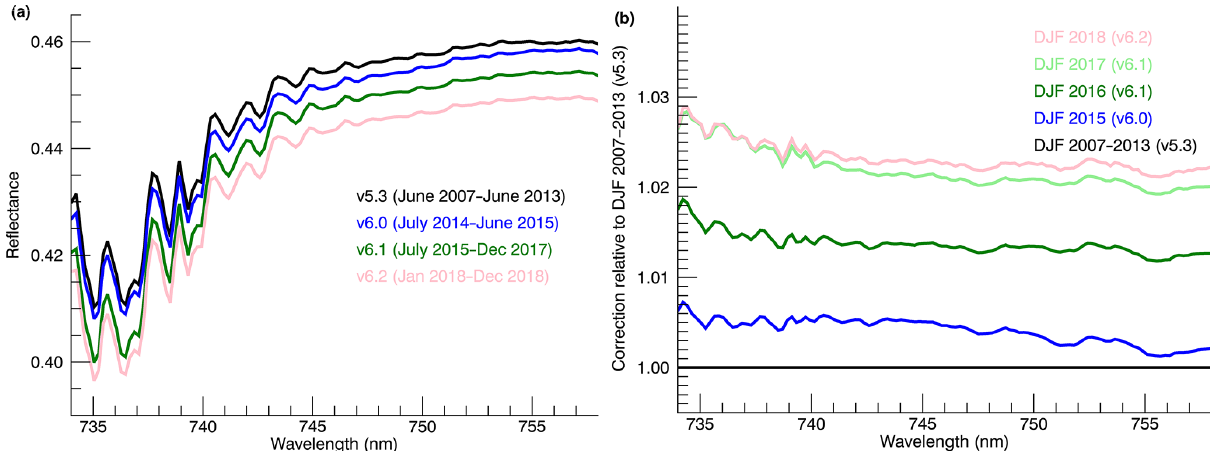
Figure 6. (a) Average reflectance spectra over the Sahara reference area for the different processor versions of GOME-2A. For version 5.3, only scenes with viewing zenith angles < 35 ◦ have been selected to stay consistent with the viewing geometries after the detector switch in June 2013. (b) Spectral corrections calculated as in footnote 2 for the winter seasons following the level-1 processor version changes.